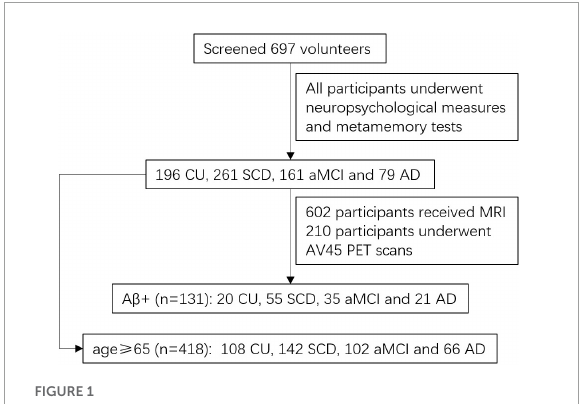
FIGURE1 A flowchart of participant